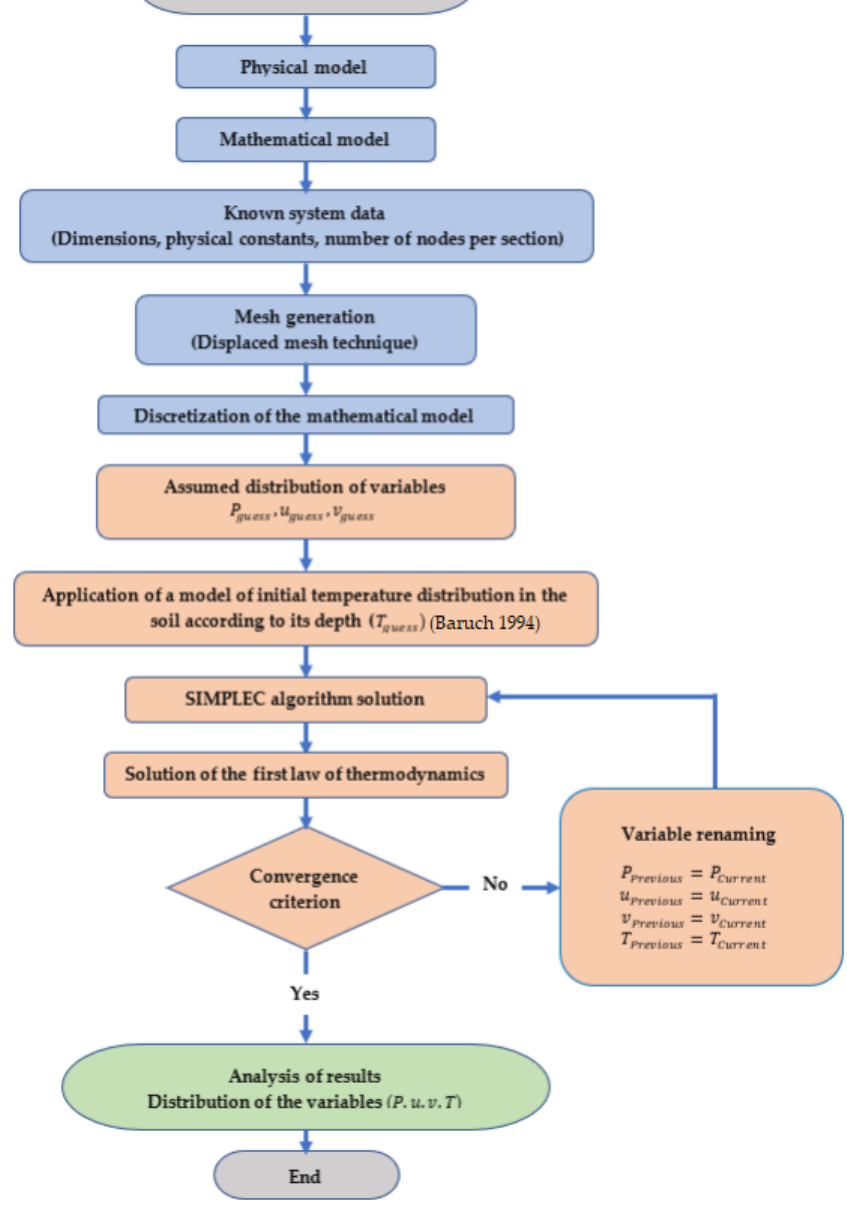
Figure 3. Flow chart of the methodology used in this work